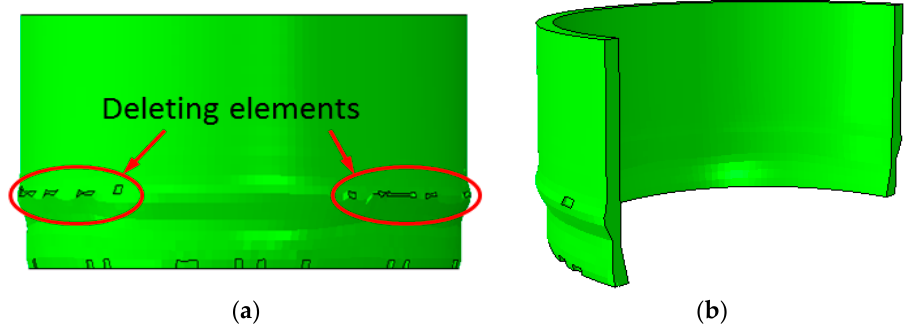
Figure 7. Crack defects in simulation in the ( a ) outer surface and ( b ) inner surface of tube at wall thickness reduction ratio of 50%.